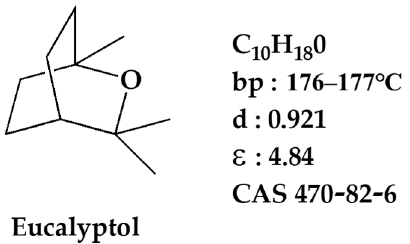
Figure 2. Structure and data of Eucalyptol. Synonyms: 1,8-Cineole, 1,3,3-trimethyl-2-oxabicy- clo[2.2.2]octane.